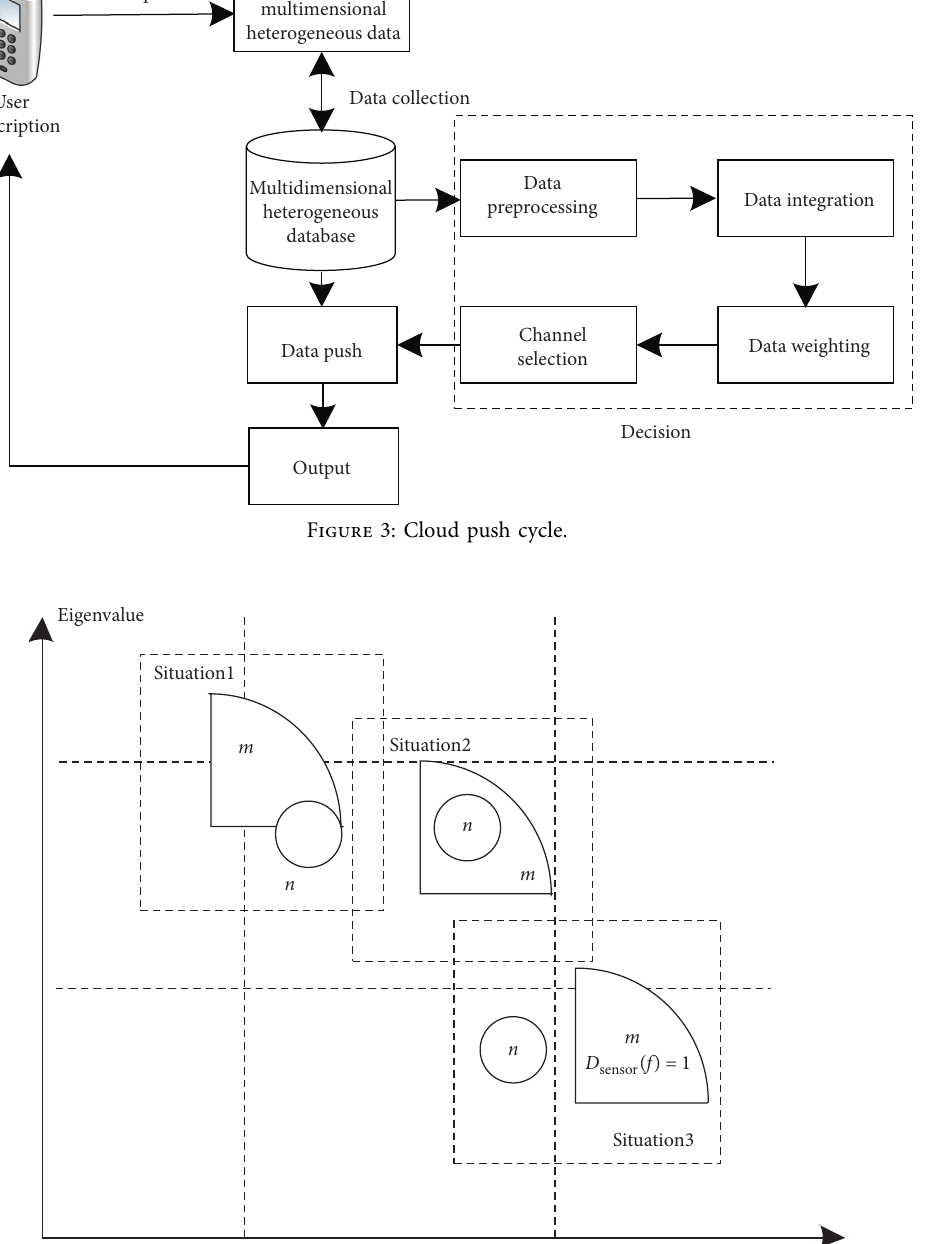
Figure 4: Process of multidimensional heterogeneous data elimination and